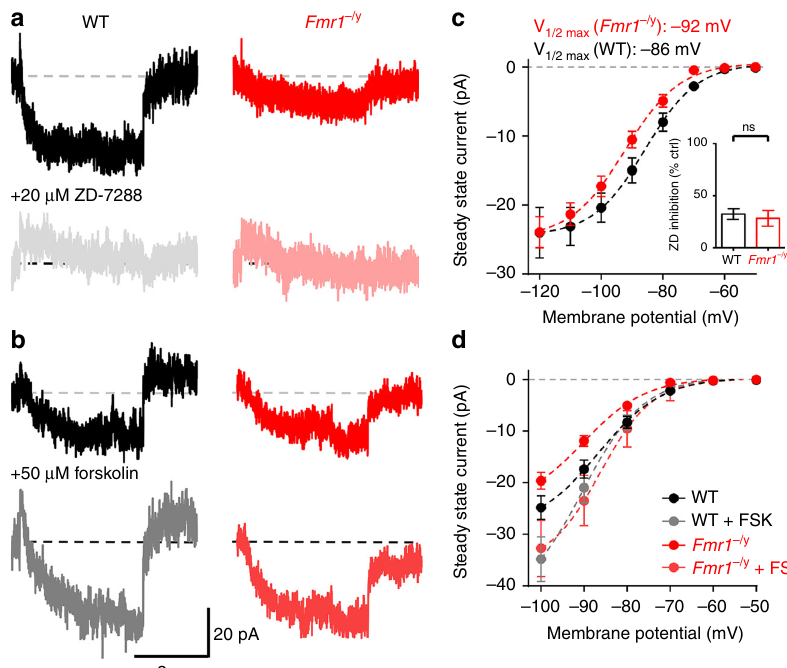
Fig. 8 Altered I h voltage sensitivity in Fmr1 − /y L4 SCs, due to reduced cyclic-AMP. a Subtracted I h traces recorded during a − 50 mV step from − 50 mV holding potential for WT (black) and Fmr1 − /y (red) L4 SCs, and following ZD application (grey, light red, respectively). b I h measured over the range of − 50 to − 120 mV for both WT and Fmr1 − /y L4 SCs fi tted with a sigmoidal curve (dashed lines). V 1/2max is indicated. Inset, I h was blocked to a similar degree by ZD in both genotypes when tested on steps to − 100 mV. c I h recorded before (top) and after (bottom) application of forskolin. d Quanti fi cation of I h responses over the range of − 50 to − 100 mV, fi tted with a sigmoidal curve. All data are shown as mean ± SEM and source data for all plots are provided